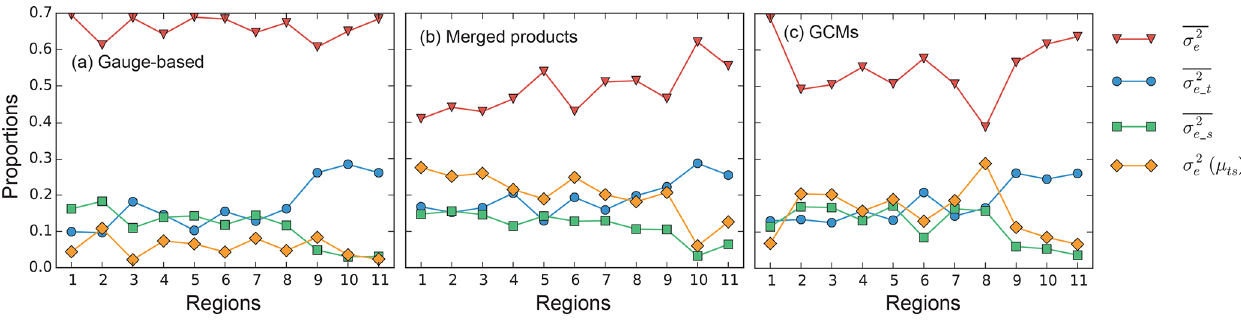
Figure 11. Proportions of the four components in Eq. (30) to V e of the ensemble datasets in each of the three different precipitation groups: (a) gauge-based products, (b) merged products and (c) GCMs. The contribution is normalized so that their sum is 1.0 for each region. Among the four components, σ 2 e_t and σ 2 e_s are associated with the two classic metrics N.s.std and N.t.std,